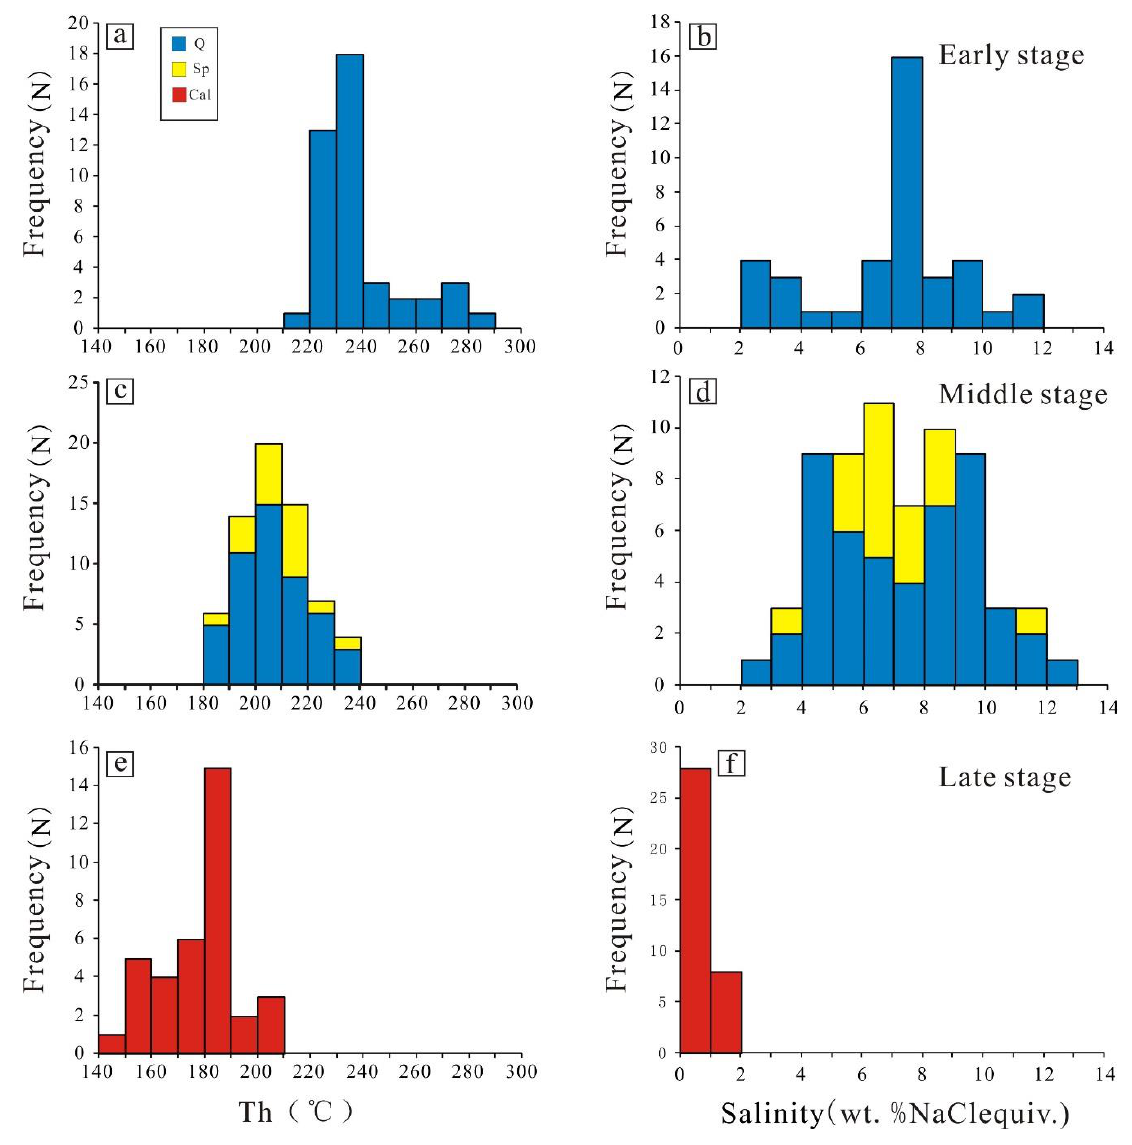
Figure 9. The frequency histograms of the total homogenization temperatures (Th) and salinities of the fluid inclusions from different stages of the Changkeng – Fuwan Ag deposit. Early stage ( a , b ); middle stage ( c , d ) and late stage ( e , f ). Qtz, quartz; Cal, calcite; Sp, sphalerite.